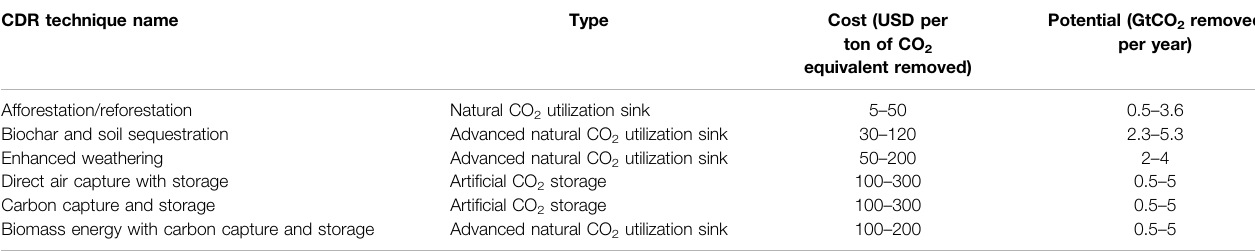
TABLE 1| AnabridgedlistofCDRtechniques analyzed bytheIPCC fortheirCO 2 removal potentialingigatons andtheassociatedcostsonanannual basis.Severalstudies providingarangeofvaluesforcostandpotentialforeachtechniquewereconsidered,howevervaluesreportedbyFussetal.weredeemedthemostrealisticestimations by the